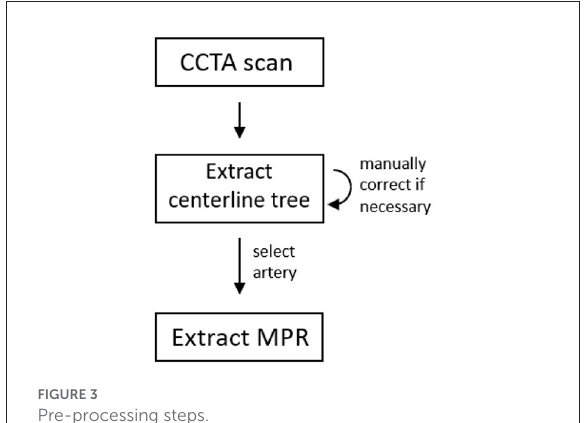
FIGURE3 Pre-processing